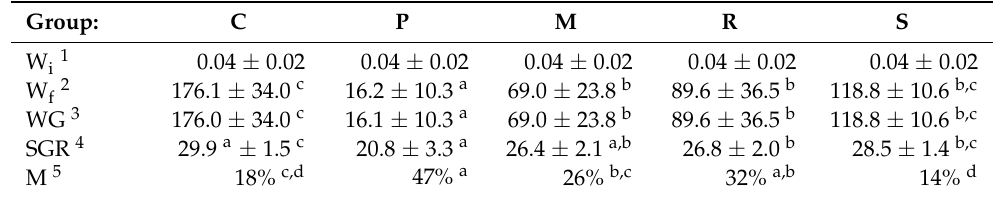
Table 3. Growth performance and mortalities of Black soldier fly larvae Hermetia illuscens feeding on chicken feed (control, C), potato protein (P), maize silage (M), rapeseed oil cake (R), soybean meal (S) substrate over an experimental period of 28 d. Significant differences between groups are indicated by different letters ( p > 0.05, n = 10).